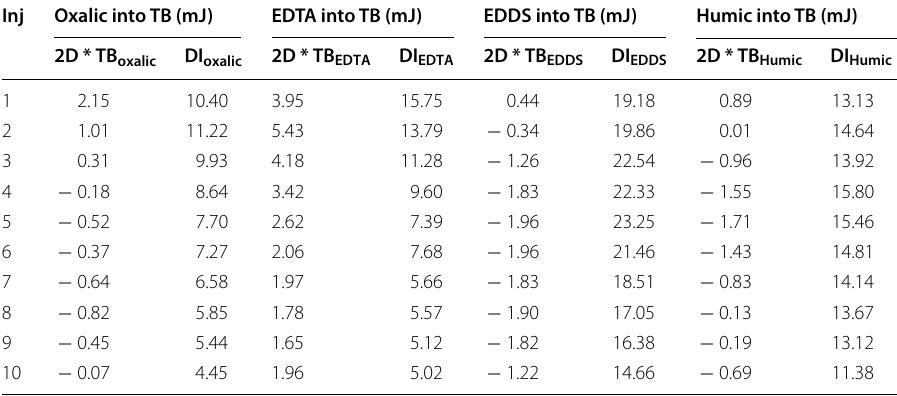
Table 6 Heat values for fluid–fluid (2D * TB chelating or DI chelating into TB) Inj Oxalic into TB